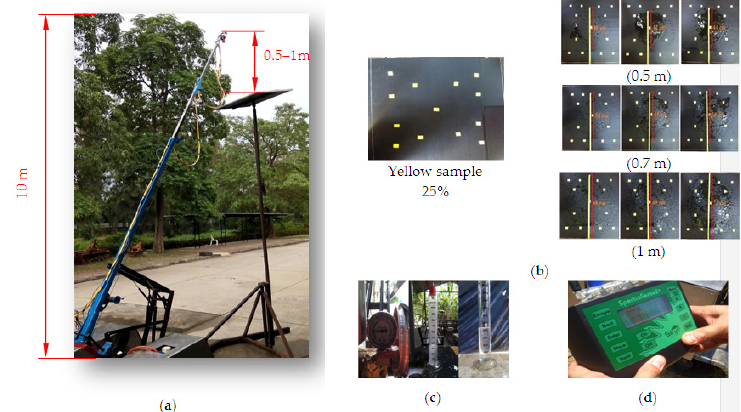
Figure 4. Experimental setup for the calibration of spraying, ( a )Variable sprayer set up; ( b )Test with a 25% yellow sample at different heights from the nozzle; ( c ) Average fluid flow rate determination; ( d ) SKR 1800 (Skye Instruments, Ltd., Powys, UK) illumination